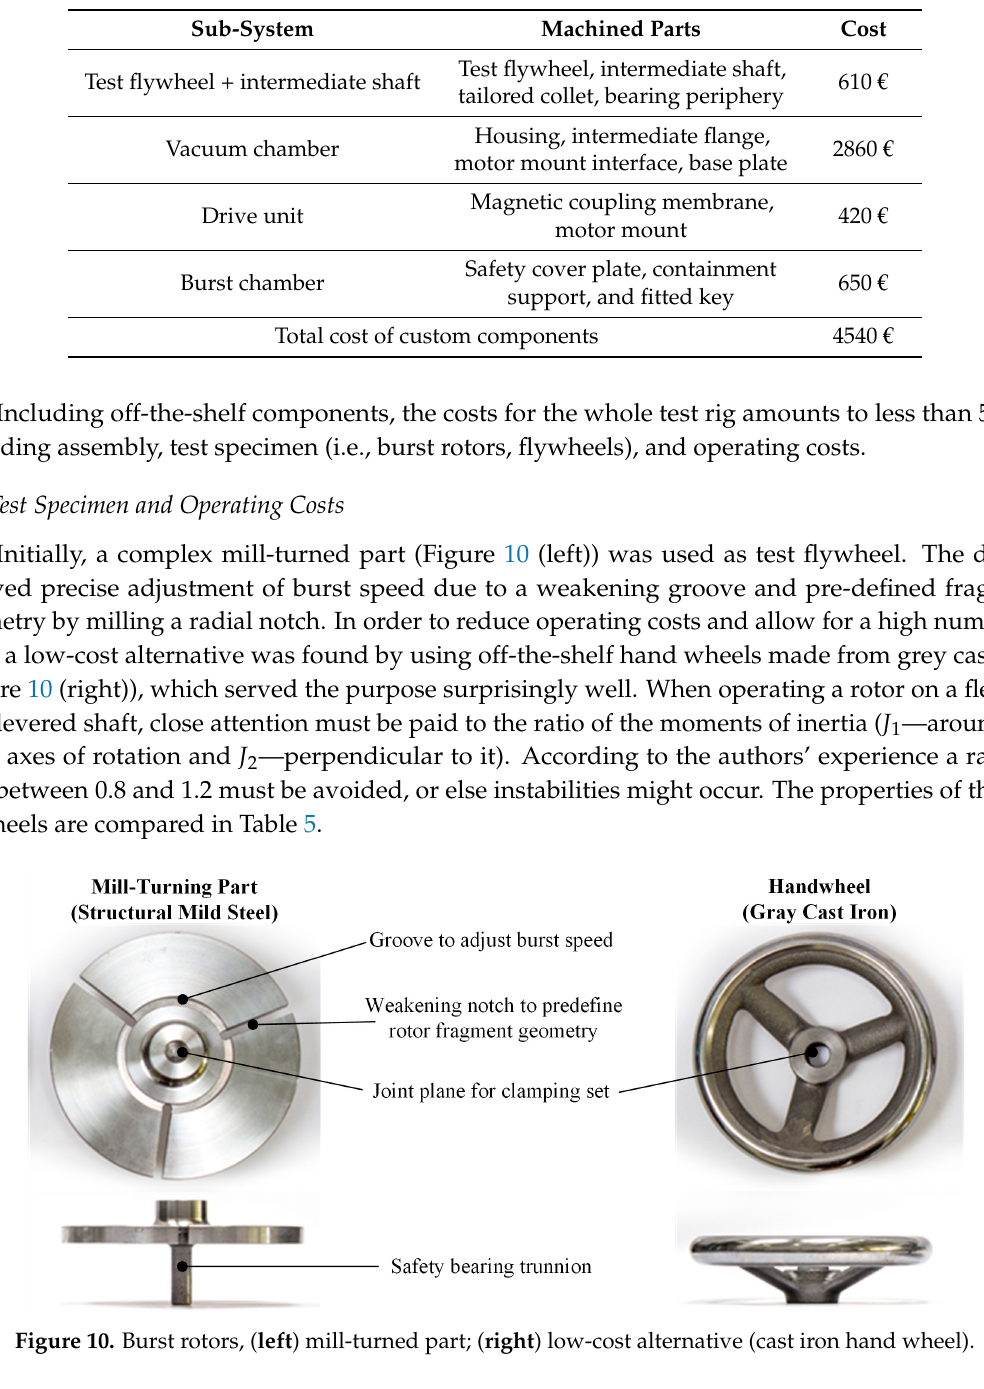
Table 5. Comparison of properties—Custom-made mill-turned rotor vs. off-the-shelf cast iron hand wheel